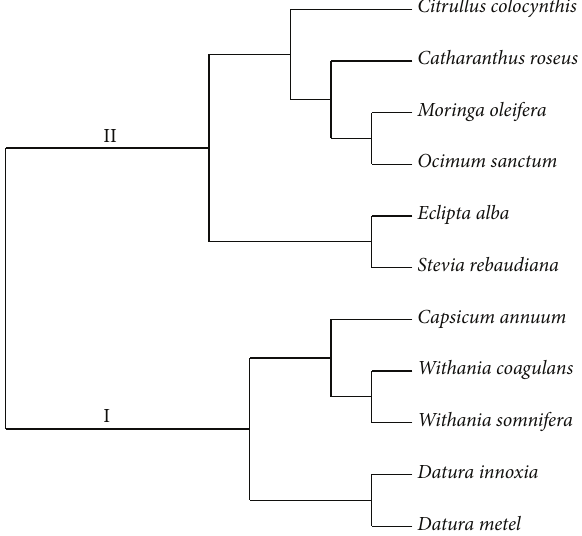
Figure 4: A dendrogram of genetic relationships revealed by 35 annotated EST-SSR markers, based on neighbor-joining and Jaccard’s algorithm using free tree and tree view